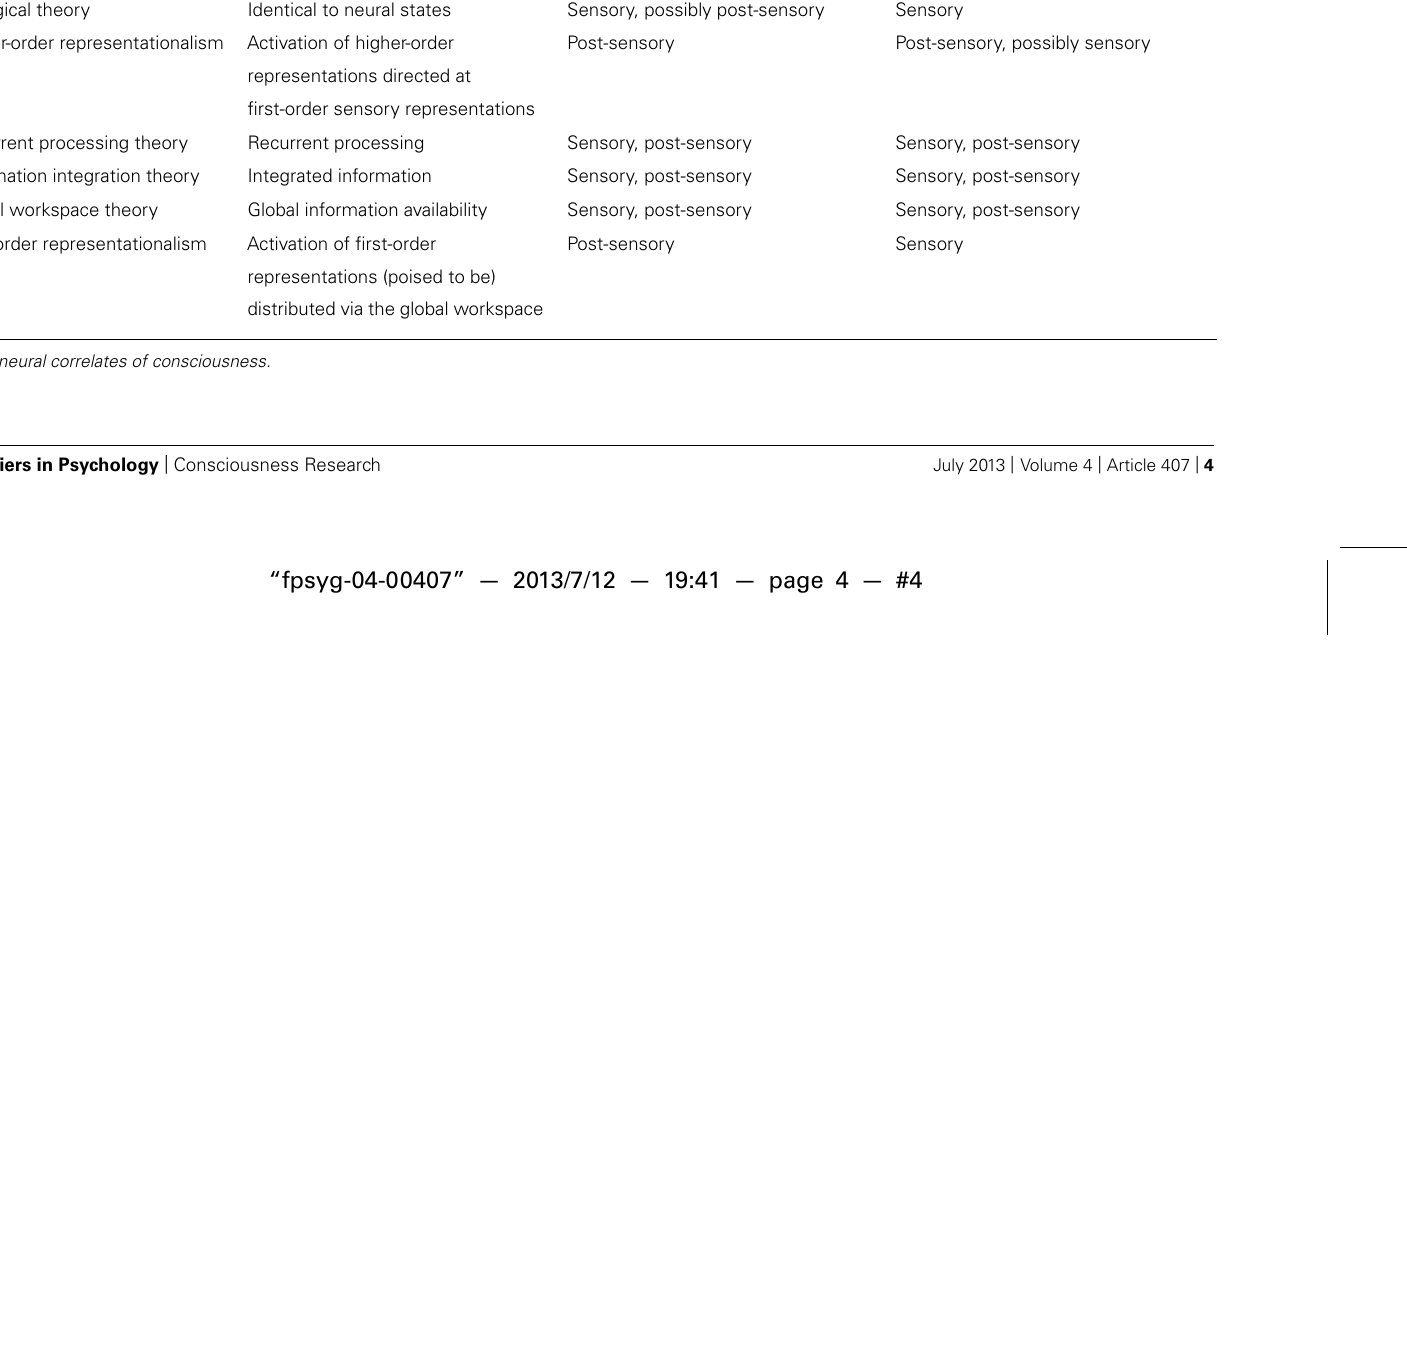
Table 1 |Theories of consciousness. Theory Consciousness is ...